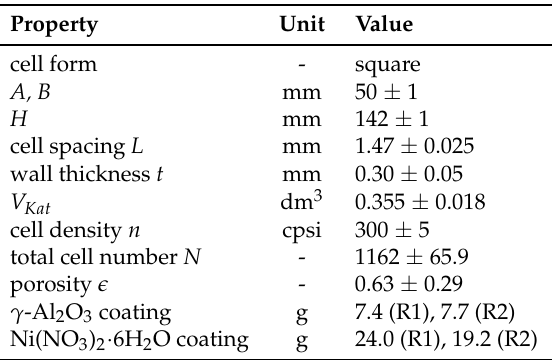
Table 2. Properties of the honeycomb catalyst.